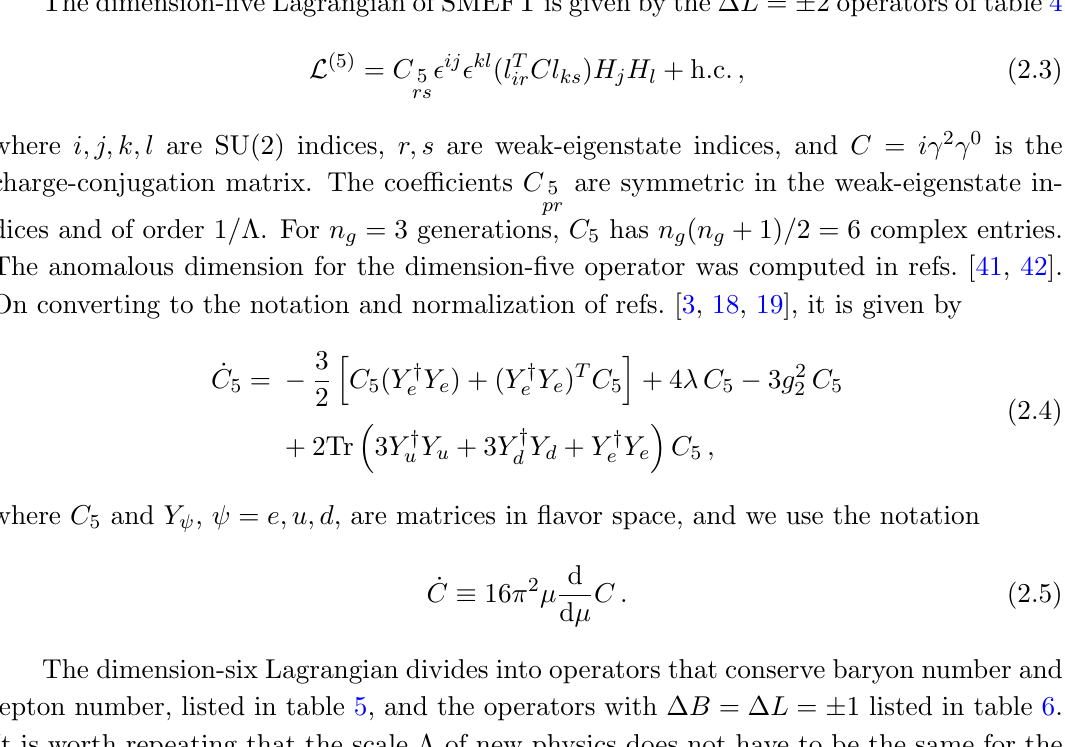
Table 1 . Number and quantum numbers of operators in SMEFT at dimensions five and six. The first column gives the operator dimension d , and the second column gives the ∆ B and ∆ L quantum numbers. The third and fourth columns list the number of Hermitian operators in SMEFT for n g = 1 and n g = 3 generations of fermions, split according to their sign under CP . the notation of refs. [3, 18, 19], where p, r, s, t are weak-eigenstate indices, 1 and powers of 1 / Λ are included in the coefficients C